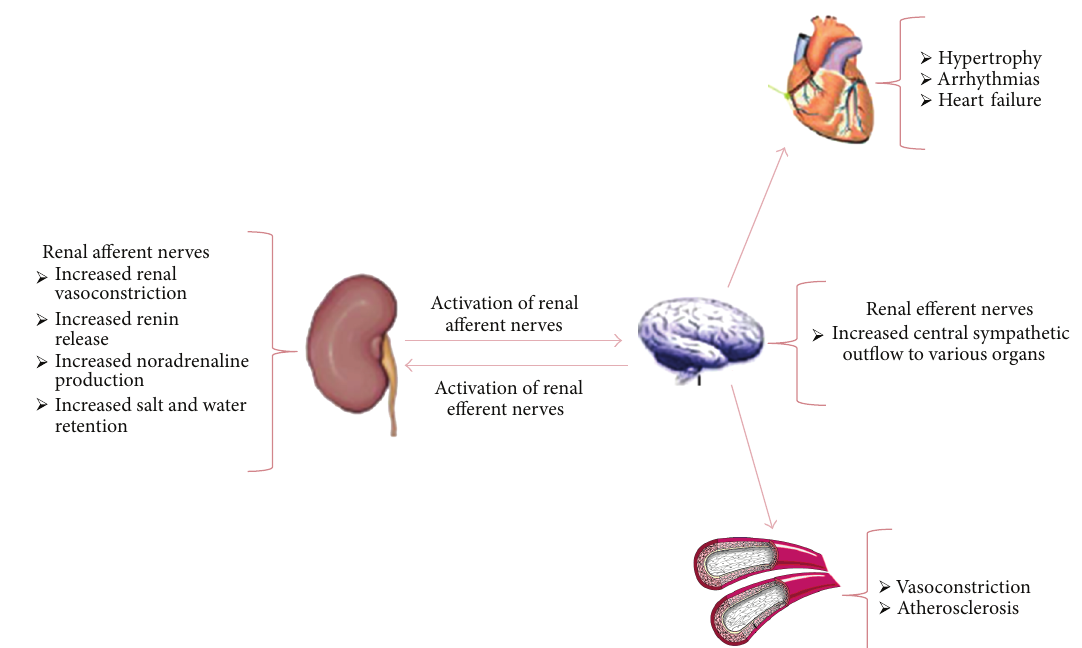
Figure 1: Activation of renal nerves and their actions in different organs. Stimulation of the renal sympathetic efferent nerves causes renin release, sodium retention, and reduced renal blood flow, factors which cause hypertension. Elevated afferent renal sensory nerve signals are centrally integrated in the hypothalamic region and result in increased sympathetic outflow directed to various regions, including the kidneys, the skeletal muscle vasculature, and the heart, which contributes substantially to elevated peripheral vascular resistance, vascular remodeling, and left ventricular hypertrophy.